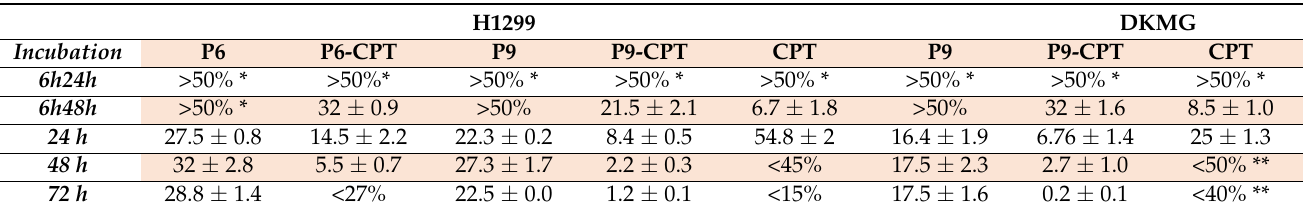
Table 1. IC 50 values ( µ M) of P6, P6-CPT, P9, and P9-CPT on H1299, DKMG cells. IC 50 values were calculated using non-linear regression. H1299